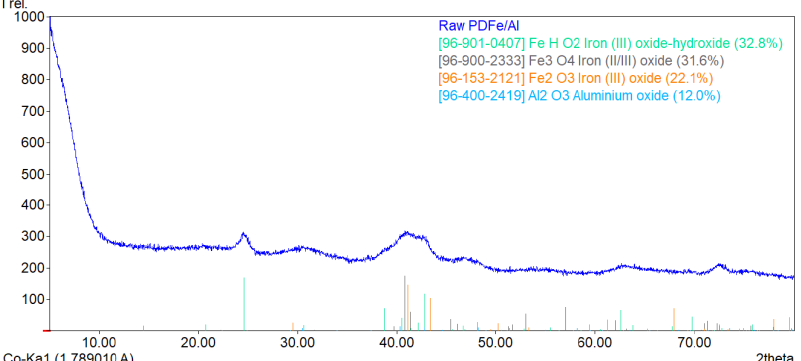
Figure 2. XRD diffractogram of the PDFe/Al before Cr(VI) adsorption. Error between selected phases and experimental profile = 3.3%.